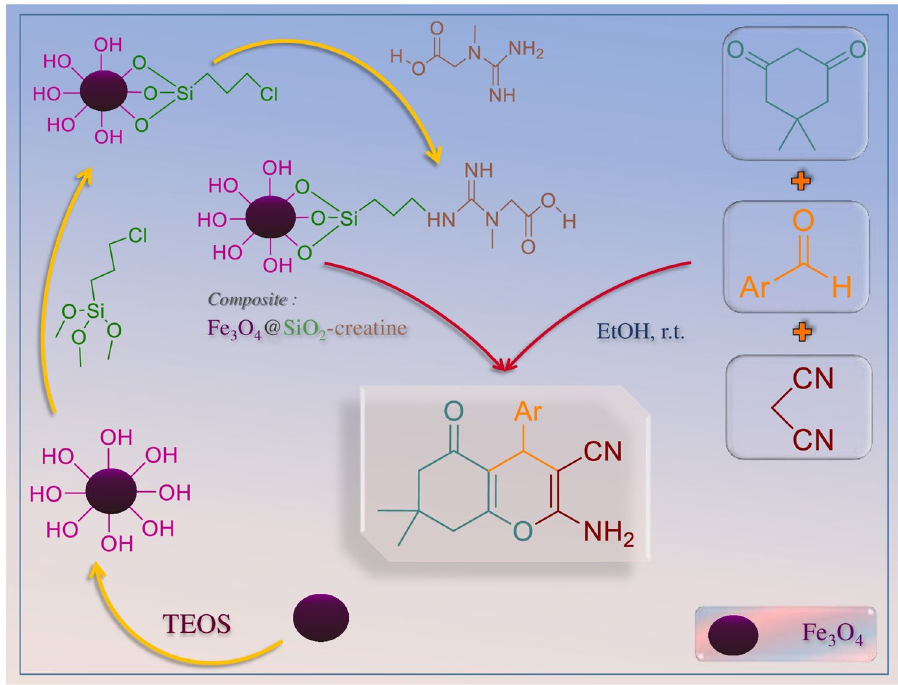
Figure 1. Preparation of creatine-functionalized Fe 3 O 4 @SiO 2 NPs and synthesis of 4H-chromene derivatives